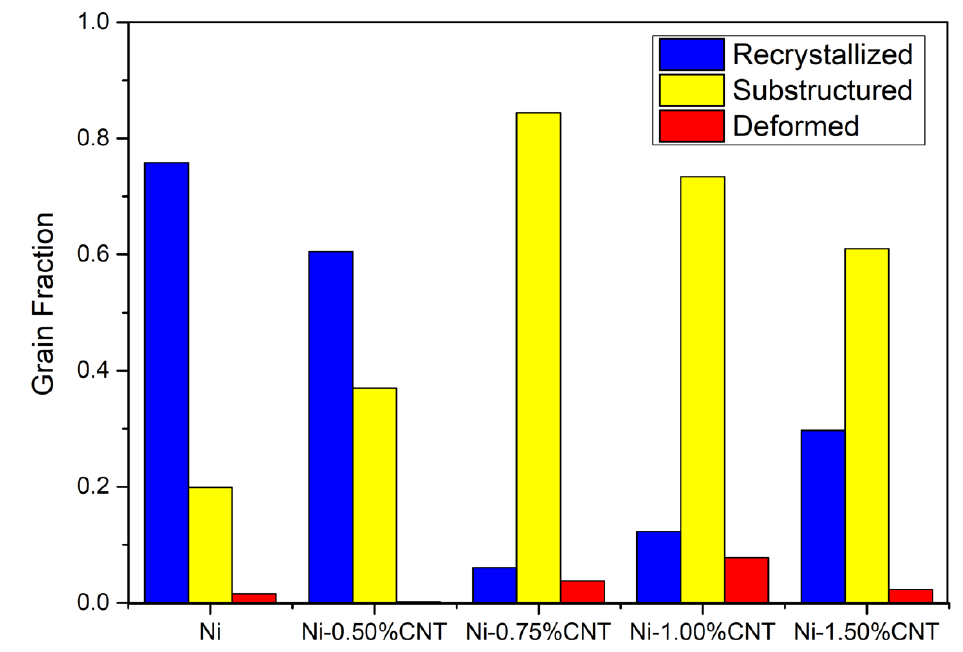
Figure 15. Distribution of recrystallized grains for Ni and nanocomposites with different volume fractions.